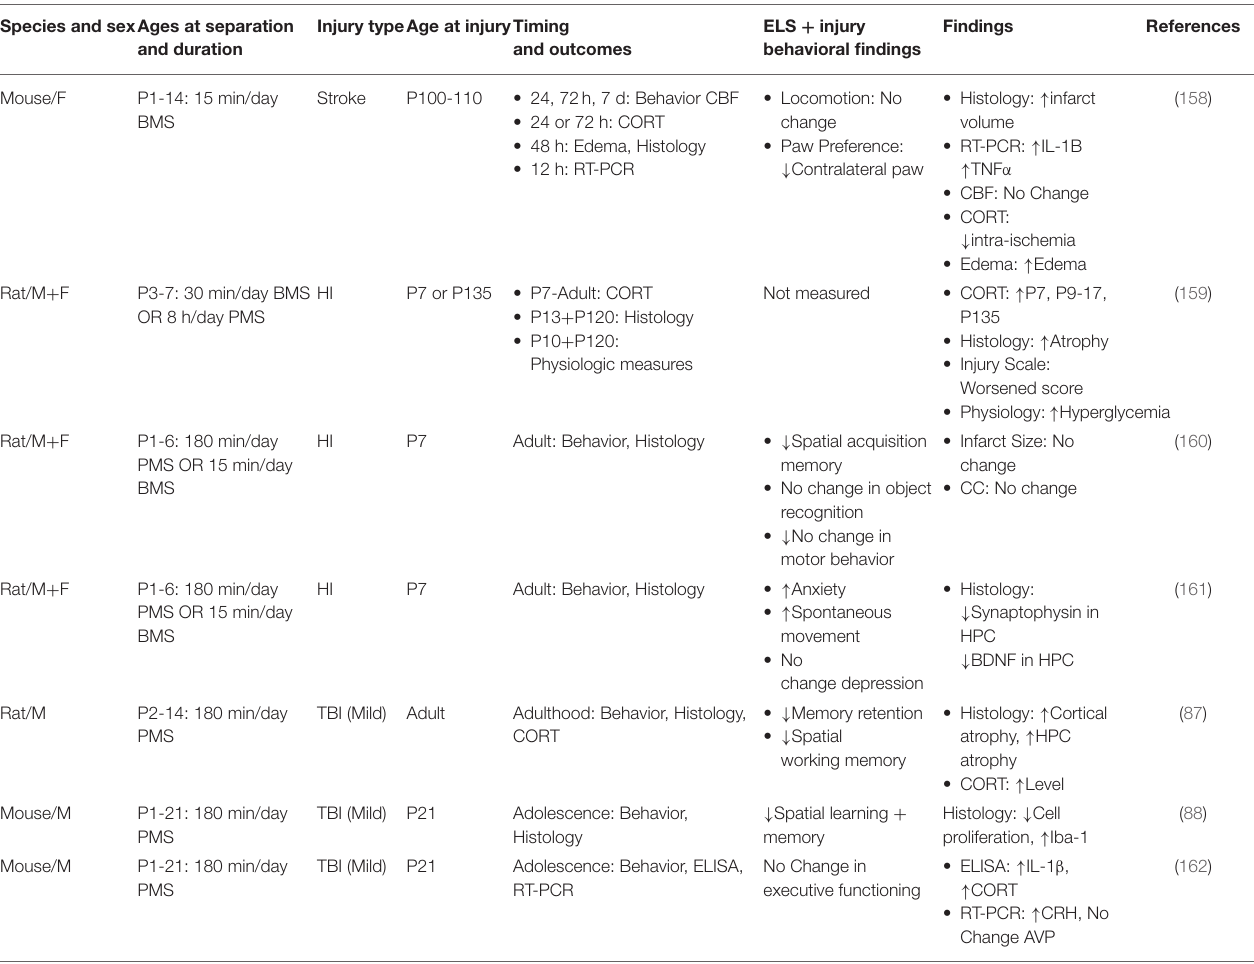
TABLE 3 | ELS prior to neonatal hypoxia-ischemia, stroke or TBI. Species and sexAges at separation and